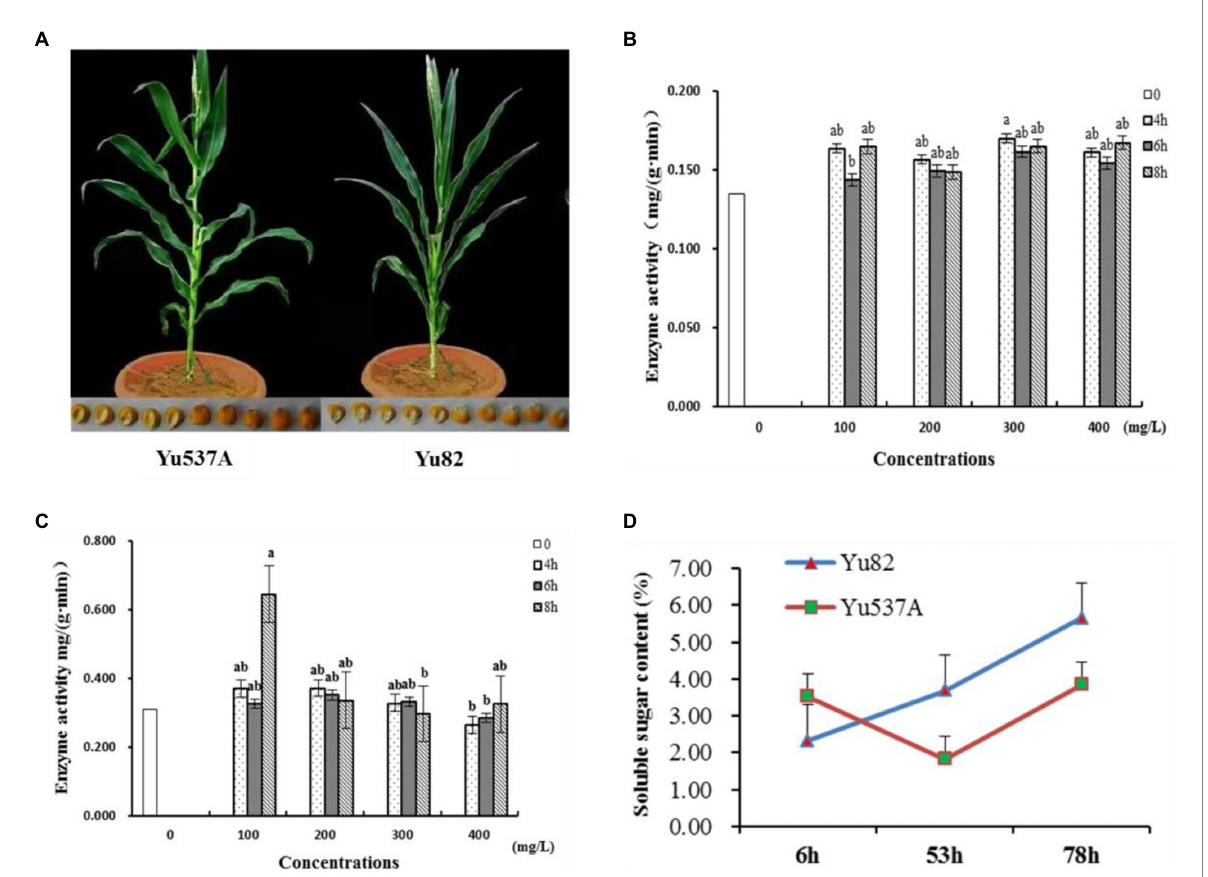
FIGURE 1 Analysis of enzyme activity of α -hydrolase and β -hydrolase, and soluble sugar content under different treatments of GA3 (A) , Phenotypes of two maize inbred lines Yu537A and Yu82. (B) , Enzyme activity analysis of α -hydrolase under different treatments of GA3. X -axis represents the concentrations of GA3 while Y -axis represents enzyme activity of α -hydrolase. Different columns present treatment time. (C) , Enzyme activity analysis of β -hydrolase under different treatments of GA3. X -axis represents the concentrations of GA3 while Y -axis represents enzyme activity of β -hydrolase. Different columns present treatment time. (D) , Soluble sugar content analysis of two maize inbred lines under different treatments of GA3. X -axis represents the treatment time with GA3 while Y -axis represents soluble sugar content in two maize inbred lines. Letters a and b represent the significant differences between different groups.